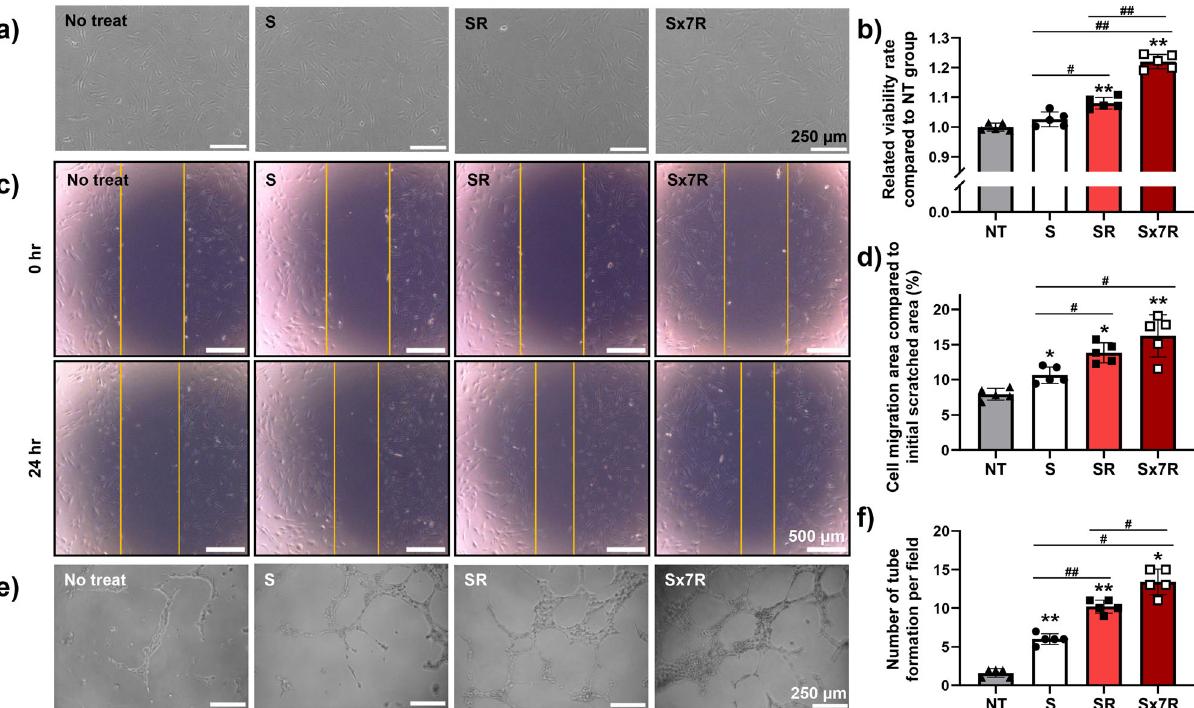
Fig. 5 Angiogenic effect of conditioned medium (CM) collected from Sx7R in vitro. a Representative light microscopy images of hADSCs after the cells were treated with the various CMs for 24 h. b Relative cellular viability of hADSCs treated with the various CMs, evaluated using CCK-8 ( n = 5, * p < 0.05 vs. no treatment (NT) group, ** p < 0.001 vs. NT group, # p < 0.05 vs. each group, ## p < 0.001 vs. each group). c , d Representative image of scratch coverage in hADSCs after cells were treated with the various CMs for 24 h. The relative cell migration area compared with the initial scratch area is also shown ( n = 5, * p < 0.05 vs. NT group, ** p < 0.001 vs. NT group, # p < 0.05 vs. each group). e , f To determine the angiogenesis ability of different CMs on the HUVEC, the tube formation assay was performed to investigate HUVEC after the cells were treated with CM for 12 h ( n = 5, * p < 0.05 vs. NT group, ** p < 0.001 vs. NT group, # p < 0.05 vs. each group, ## p < 0.001 vs. each group). Data are presented as mean ±